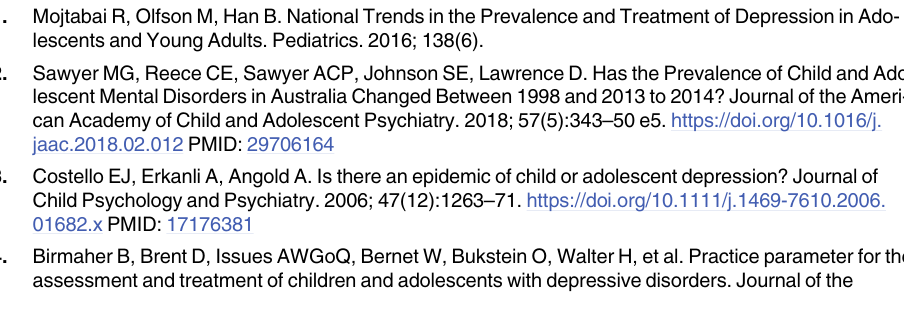
S2 Table. Means, standard deviations and independent t-test for depression or non-depres- sion for child and parent ratings on the MFQ and SMFQ. S3 Table. Means, standard deviations, analysis of variance and independent t-test for MFQ and SMFQ with child and parent ratings separately for boys and girls and for children and adolescents. S4 Table. Checklist of StarD reporting